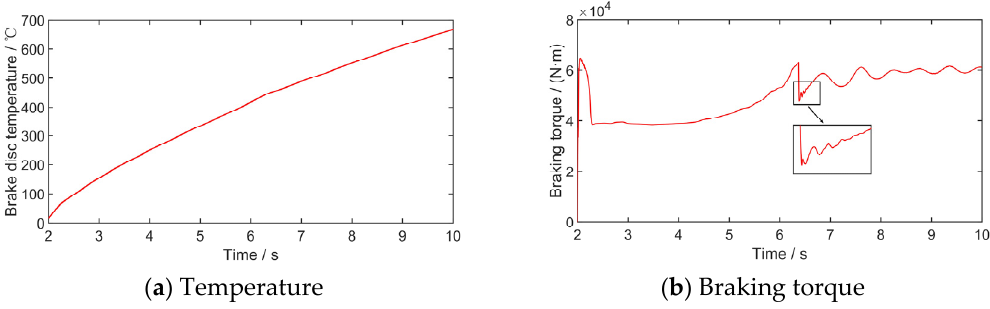
Figure 9. Friction characteristics analysis of a C/SiC brake disc.